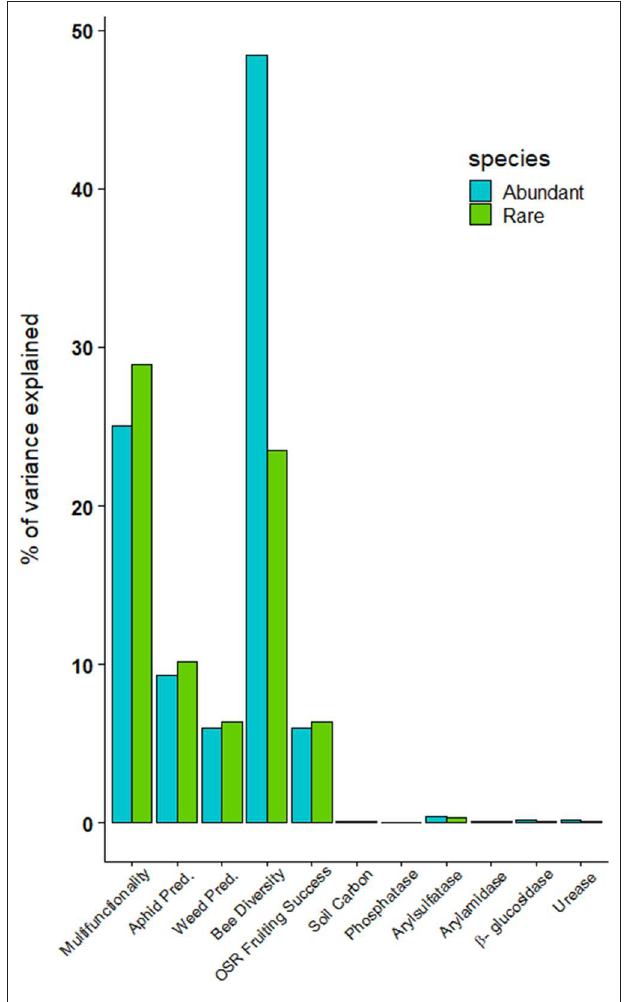
FIGURE 5 | Percentage of variance on EF-multifunctionality and each ecological functions explained by the number of locally abundant (Blue) and rare (Green) weed species which were defined using the number of species with an plant abundance < 60% quantile and lower than 40% quantile of the weed abundance